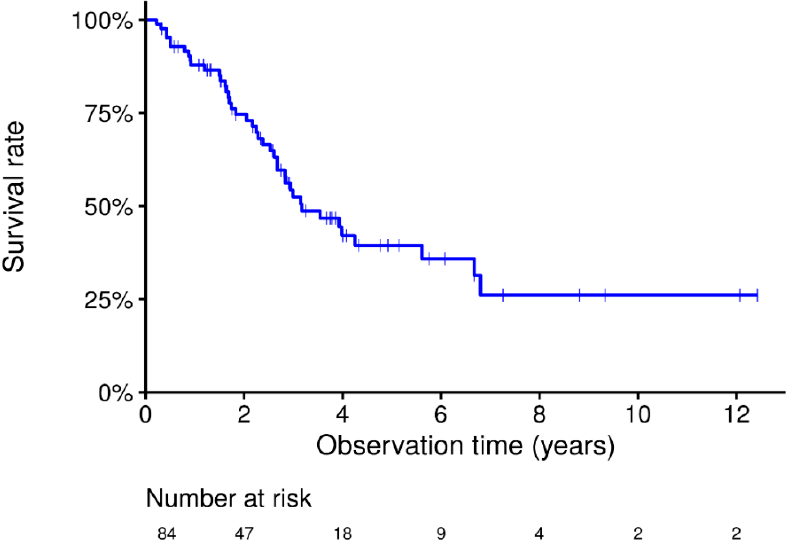
Figure 1. Kaplan-Meier survival curves in the total cohort of idiopathic PPFE. Overall survival of the 84 patients with idiopathic PPFE. Survival at 5 and 10 years was 38.5% and 26.1%, respectively. A multivariate Cox proportional hazards model showed that being male ( HR = 6.594, 95% CI: 2.484 to 17.505) and having dyspnea ( HR = 4.484, 95% CI: 1.616 to 12.421) were risk factors for all-cause mortality (Table 2). Table 2. Multivariate Cox proportional hazard model in idiopathic PPFE patients for the mortality risk.